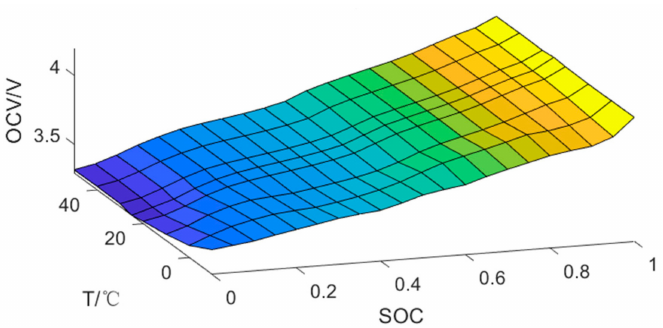
Figure 2. OCV of the ternary lithium-ion battery at different temperatures and SOC